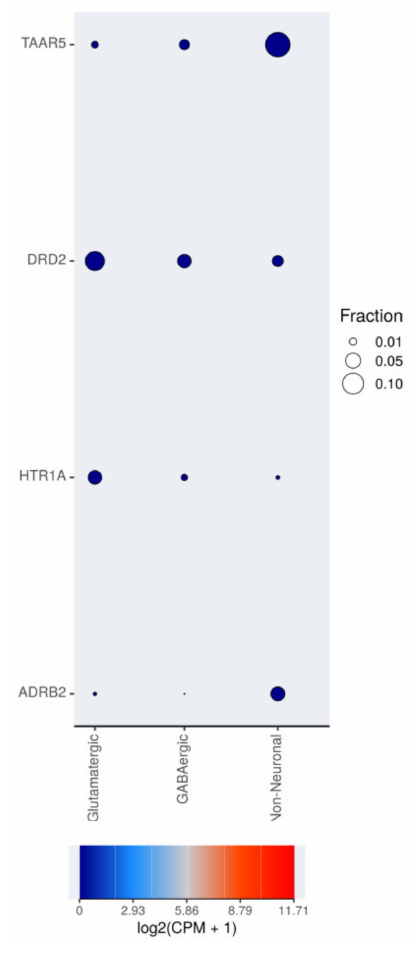
Figure 5. Single-nuclei TAAR5, DRD2, HTR1A, and ADRB2 expression in different cell types in human middle temporal gyrus. RNA-sequencing data are available on the RNAseq Data Navigator (http://celltypes.brain-map.org/rnaseq/human (accessed on 10 March 2021, [28]); the figure was generated by the RNAseq Data Navigator interactive web interface. Fraction is the fraction of cells that are positive for mRNA